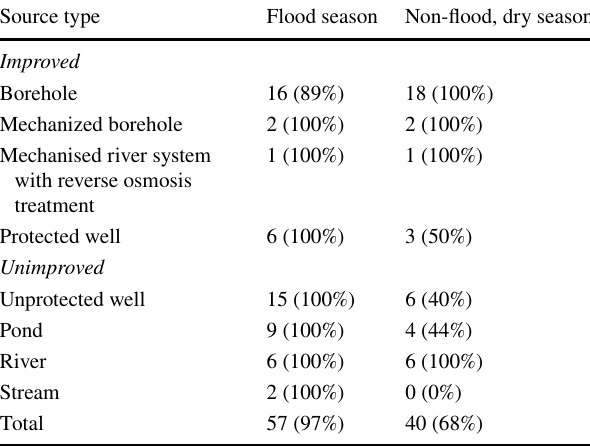
Table 1 Number and type of water points sampled during and follow- ing flooding as a percentage of those selected for sampling Source